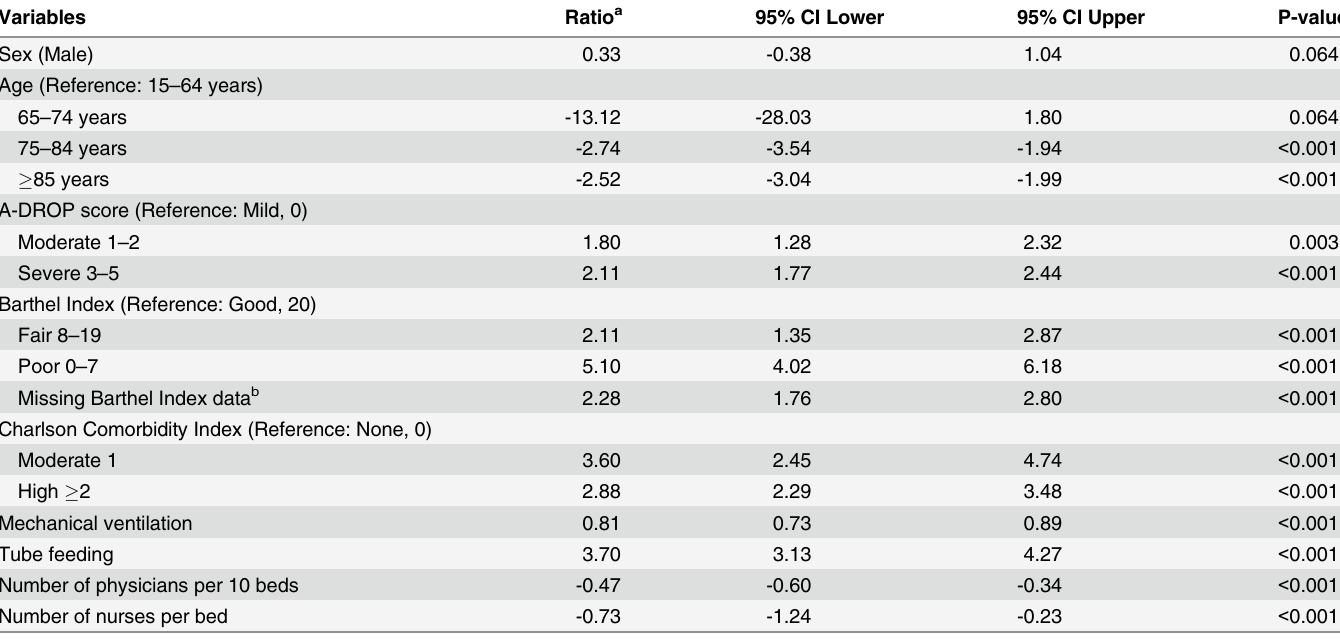
Table 4. Ratios of the indirect effects to the direct effects on total hospitalization costs (n =